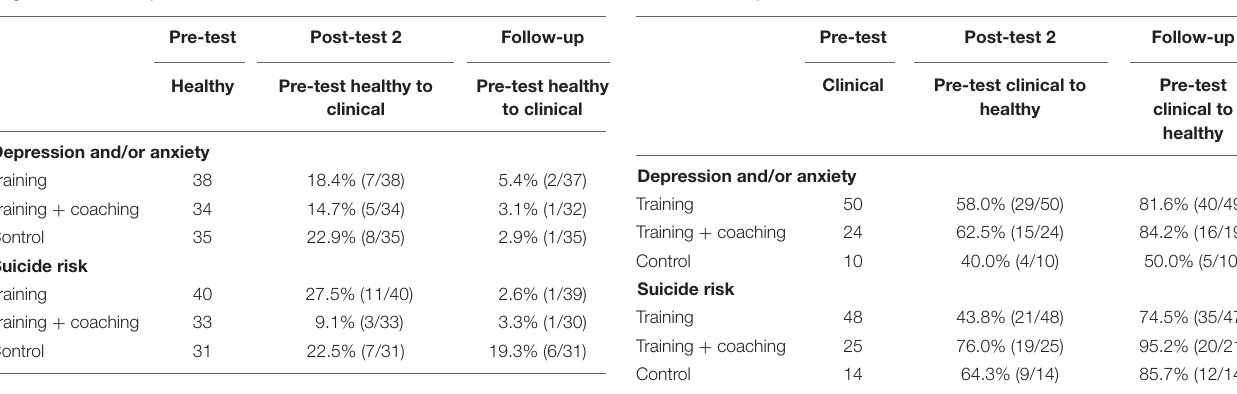
TABLE 5 | Recovery at post-test 2 and follow-up: proportions of training, training and coaching, and control students who changed their pre-test diagnosis from clinical to